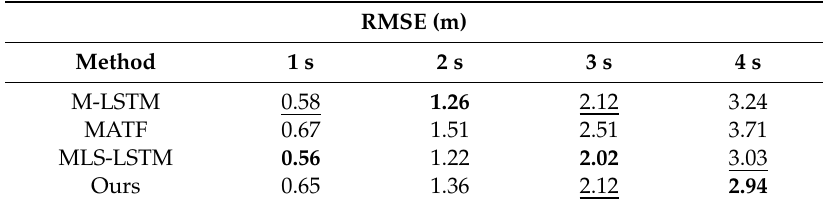
Table 3. Comparison of root mean square error (RMSE) values between the proposed method and comparative methods. The best is marked in bold and the second best is